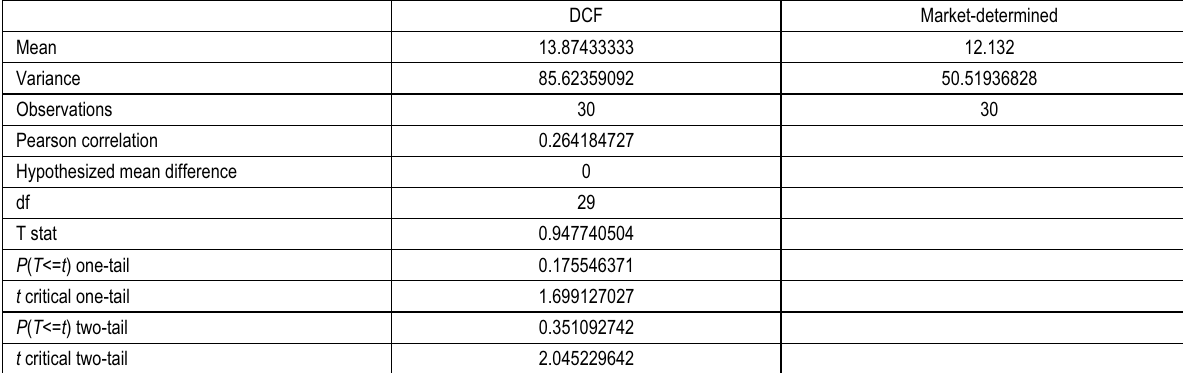
Table 1. T-test: paired two sample for means for EV/EBITDA DCF